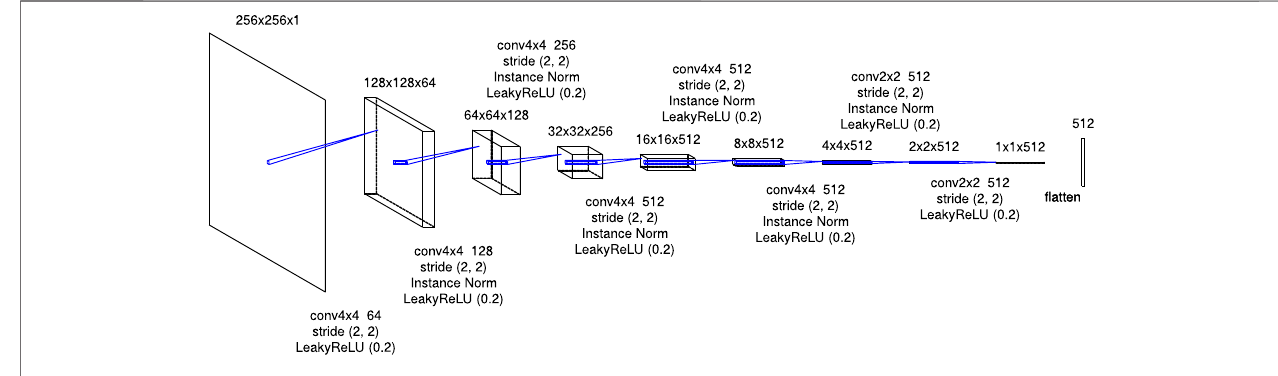
FIGURE 2 | The details of the fi rst-half of U-Net. The expression “ conv4x4 64 ” refers to a convolutional layer with a kernel size of ( 4 × 4 ) and 64 channels. Each feature map is copied and is concatenated to the feature map of the corresponding block in the latter-half of U-Net denoted in Figure 4